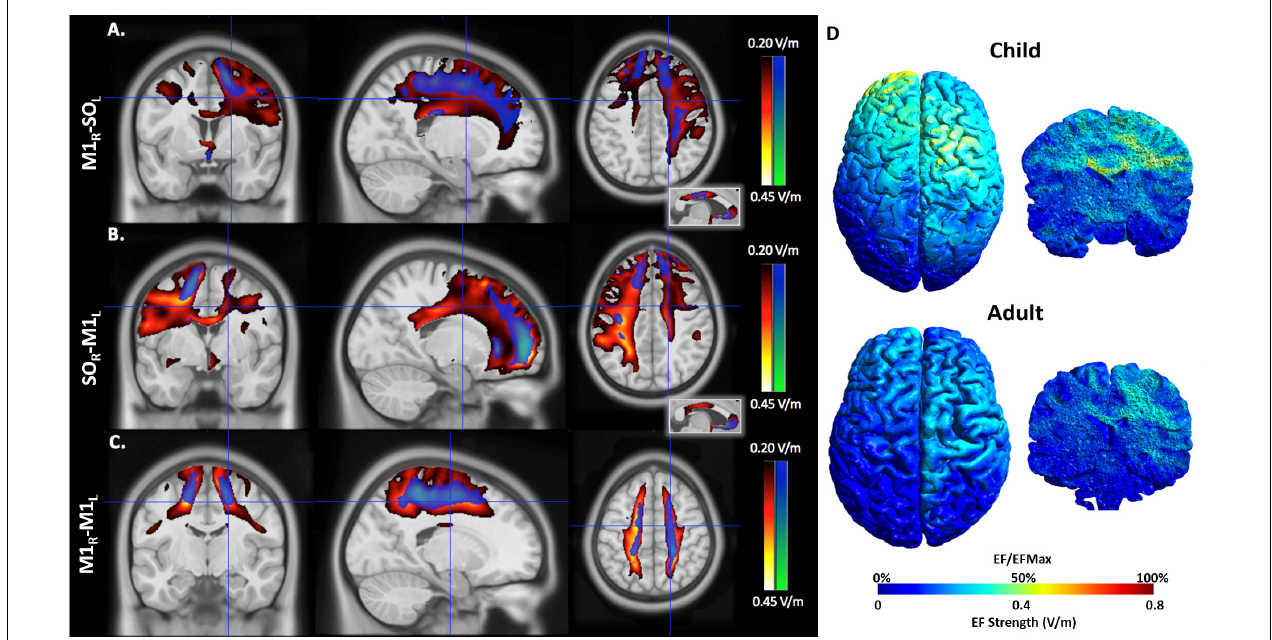
FIGURE 4 | An illustration of electric field maps induced by (A) anodal tDCS (right M1), (B) cathodal tDCS (left M1), and (C) bihemispheric tDCS montages. Shown are group mean electric field maps for children (red) and adults (blue), in the range of 0.20–0.45 V/m, overlaid on three orientations (axial, coronal, sagittal) of an MNI template brain. (D) Example of electric fields induced by anodal tDCS of right primary cortex in a 6.5 (child, top) and 43.0-year-old (adult, bottom).